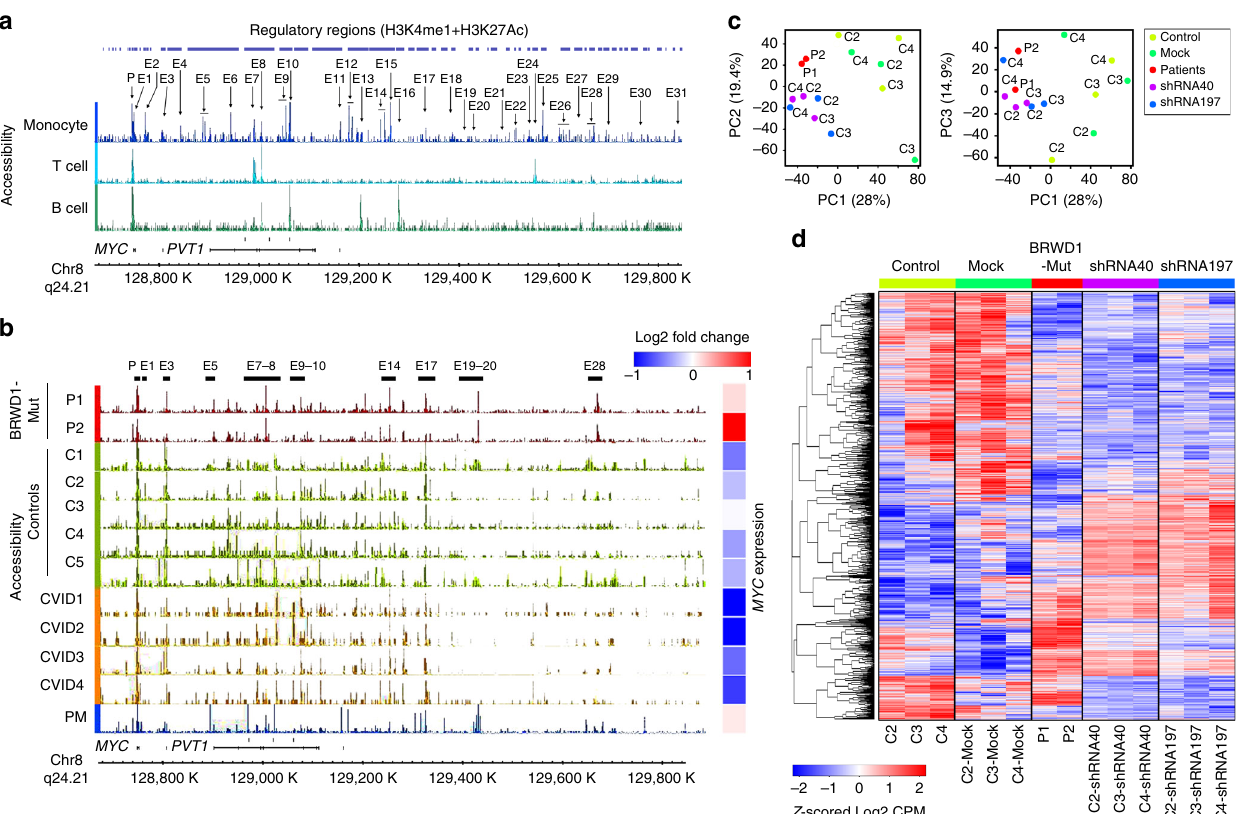
Fig. 8 BRWD1 regulates MYC and other transcriptional programs in human peripheral B cells. a Identi fi cation of possible regulatory regions of human MYC locus using accessibility, H3K4me1 and H3K27Ac ChIP-seq data from monocytes, T cells and B cells (International Human Epigenome Consortium, IHEC). b Accessibility (open chromatin) pro fi le of human MYC locus in BRWD1-Mut patients (P1 and P2), controls (C1-5), unrelated CVID patients (CVID1-4) and patients ’ mother (PM) with heatmap of MYC expression across each individual sample (right panel). c Principal component analysis of mRNA expression in EBV-transformed human peripheral blood B cells from healthy controls (C2, C3, and C5), patients (P1 and P2), mock-shRNA and BRWD1-speci fi c shRNA40 and ShRNA197 expressing controls (C2, C3, and C4). Eigenvalue statistics for the PC analysis of RNA-Seq are reported in axes. d Hierarchical clustering of differentially expressed genes identi fi ed at q < 0.05 in the above c shRNA-expressing and non-expressing EBV-transformed control cell